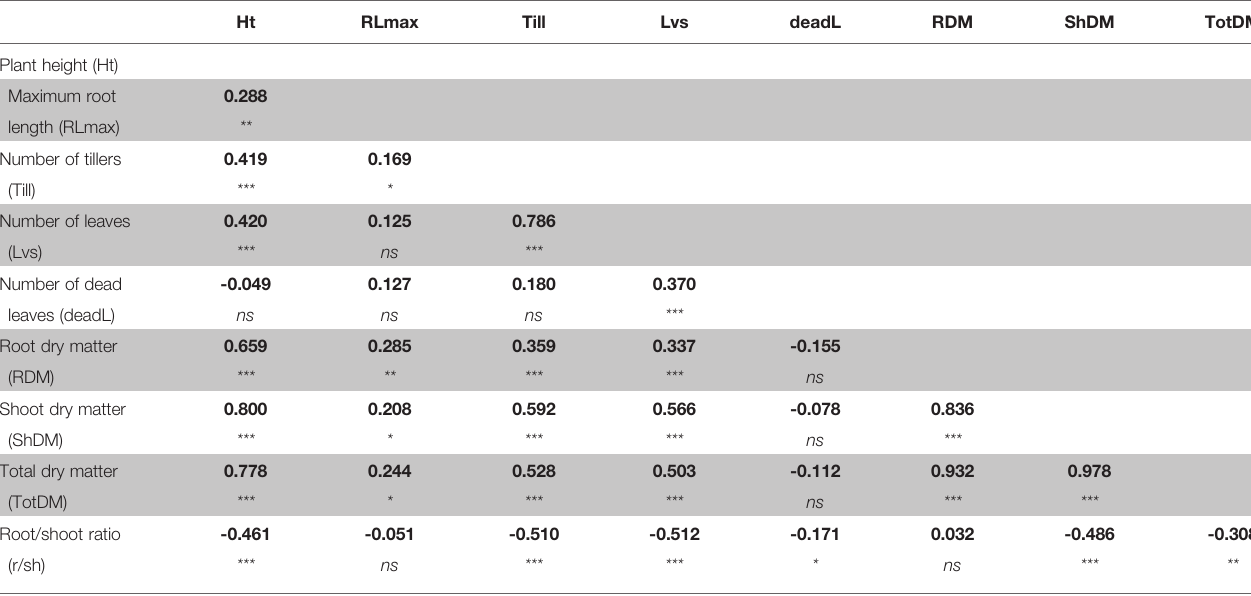
TABLE 2 | Correlation coef fi cient between phenotypic traits measured in plants grown in low-S treatment. Ht RLmax Till Lvs deadL RDM ShDM